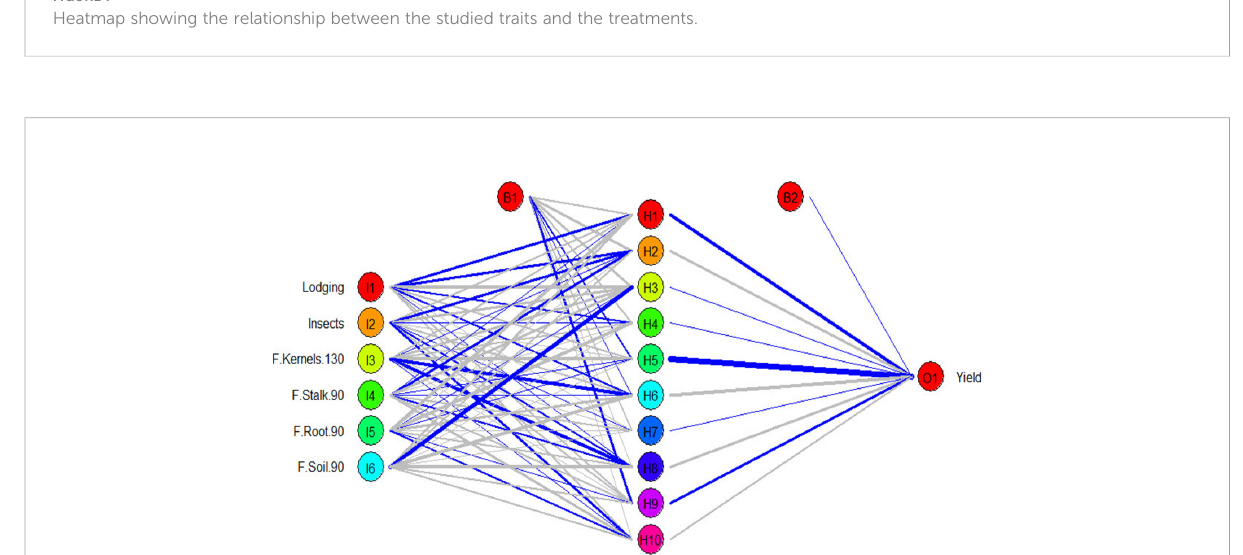
FIGURE 8 The structure of the used arti fi cial neural network in the present